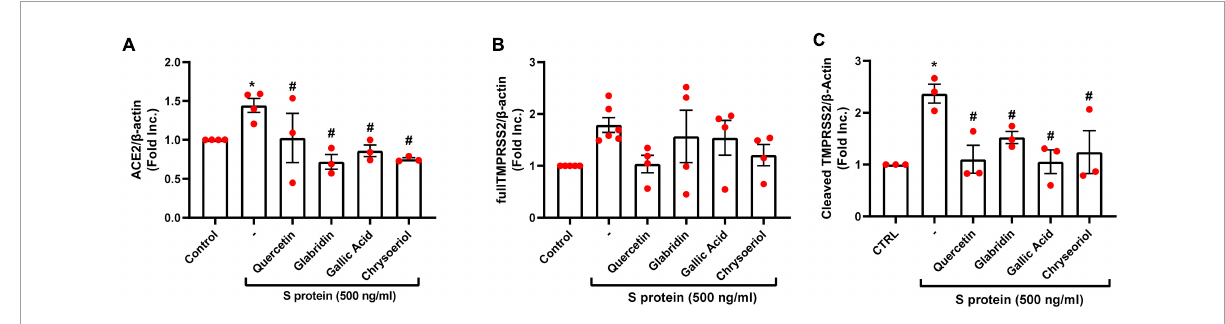
FIGURE3 Attenuation of SARS-CoV-2 spike protein-induced upregulation of ACE2/TMPRSS2 by quercetin, glabridin, gallic acid, and chrysoeriol. Bovine aortic endothelial cells (BAECs) were pretreated with viral spike protein (S protein, 500 ng/ml) for 30 min before exposure to 100 nmol/l of small molecule compounds for 24 h. (A) Grouped data of ACE2 protein expression indicating that S protein-induced upregulation in ACE2 protein abundance was completely attenuated by small molecules. n = 3–4. (B,C) Grouped data of native and cleaved TMPRSS2 protein expression indicating that S protein activated proteolytic cleavage of TMPRSS2 was near completely attenuated by small molecules. Data are shown as mean ± SEM. * p < 0.05, ** p < 0.01 vs. control group; # p < 0.05, ## p < 0.01 vs. S protein treated group by one-way